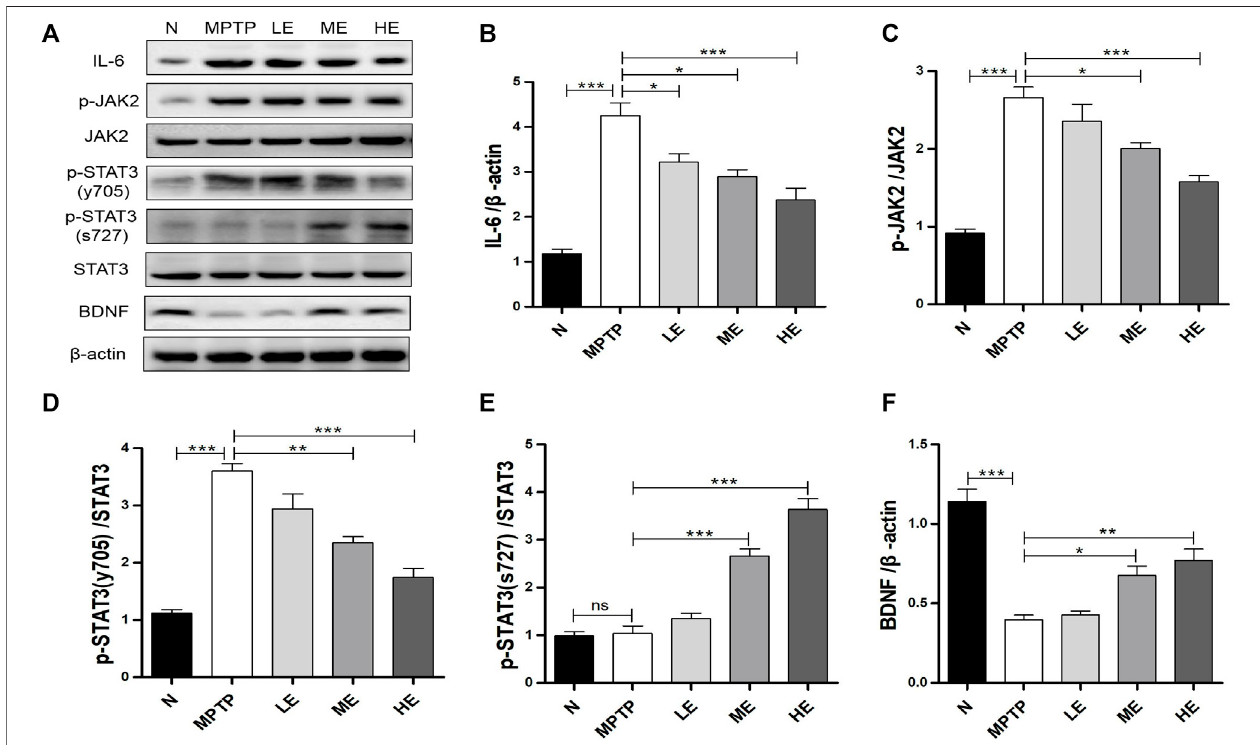
FIGURE 4 | ECH regulated IL-6/JAK2/STAT3 signaling in SN of MPTP mice. (A) Expression of IL-6, p-JAK2, JAK2, p-STAT3 (tyr705), p-STAT3 (ser727), STAT3, and BDNF in SN. (B) Western blot analysis for IL-6. (C) Western blot analysis for p-JAK2/JAK. (D) Western blot analysis for p-STAT3 (tyr705)/STAT3. (E) Western blot analysis for p-STAT3 (ser727)/STAT3. (F) Western blot analysis for BDNF. Values are presented as the mean ± SEM. * p < 0.05, ** p < 0.01, *** p < 0.001.